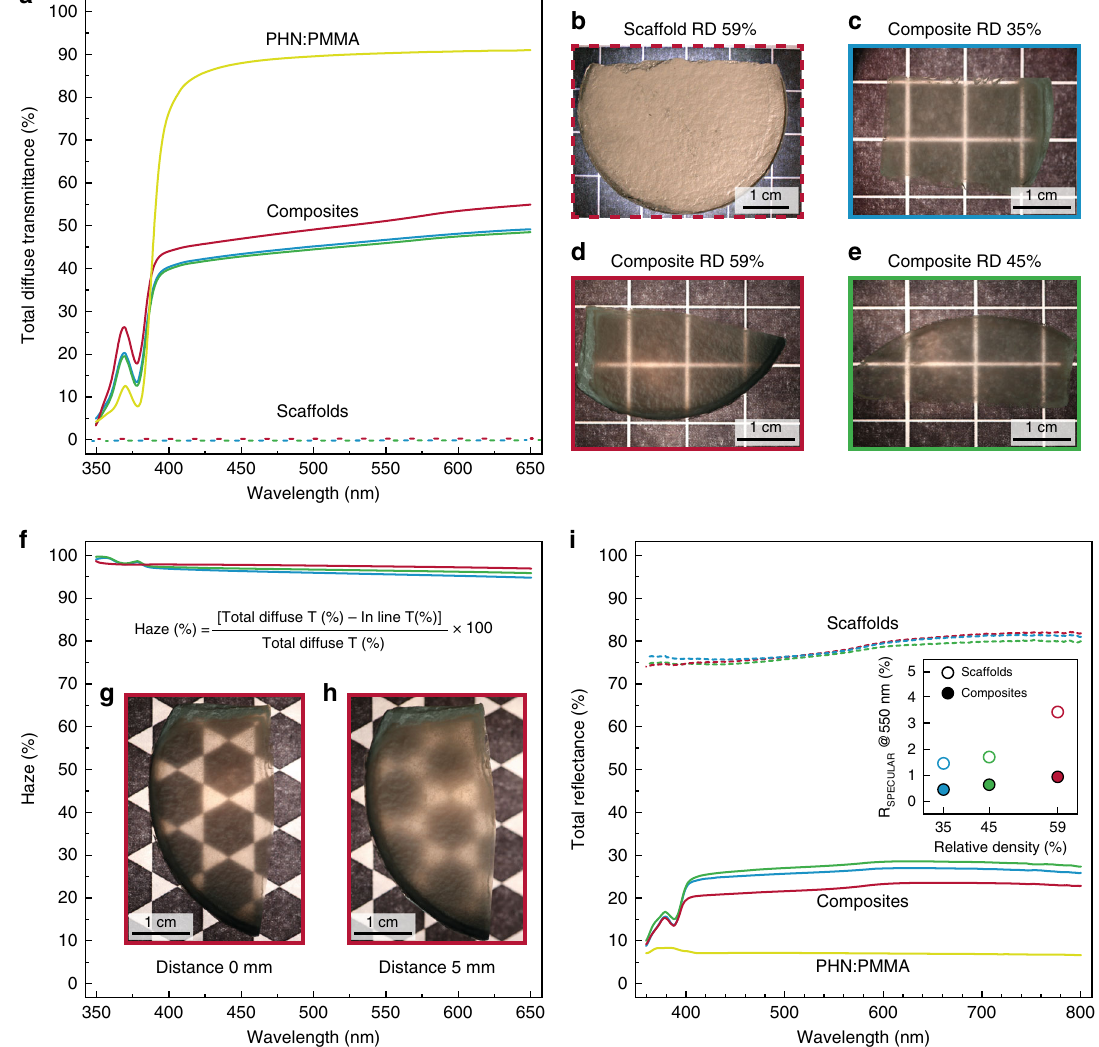
Fig. 4 Optical characterization of the composites. a Total diffuse transmittance of glass scaffolds prior to in fi ltration (dashed lines) and of composites with